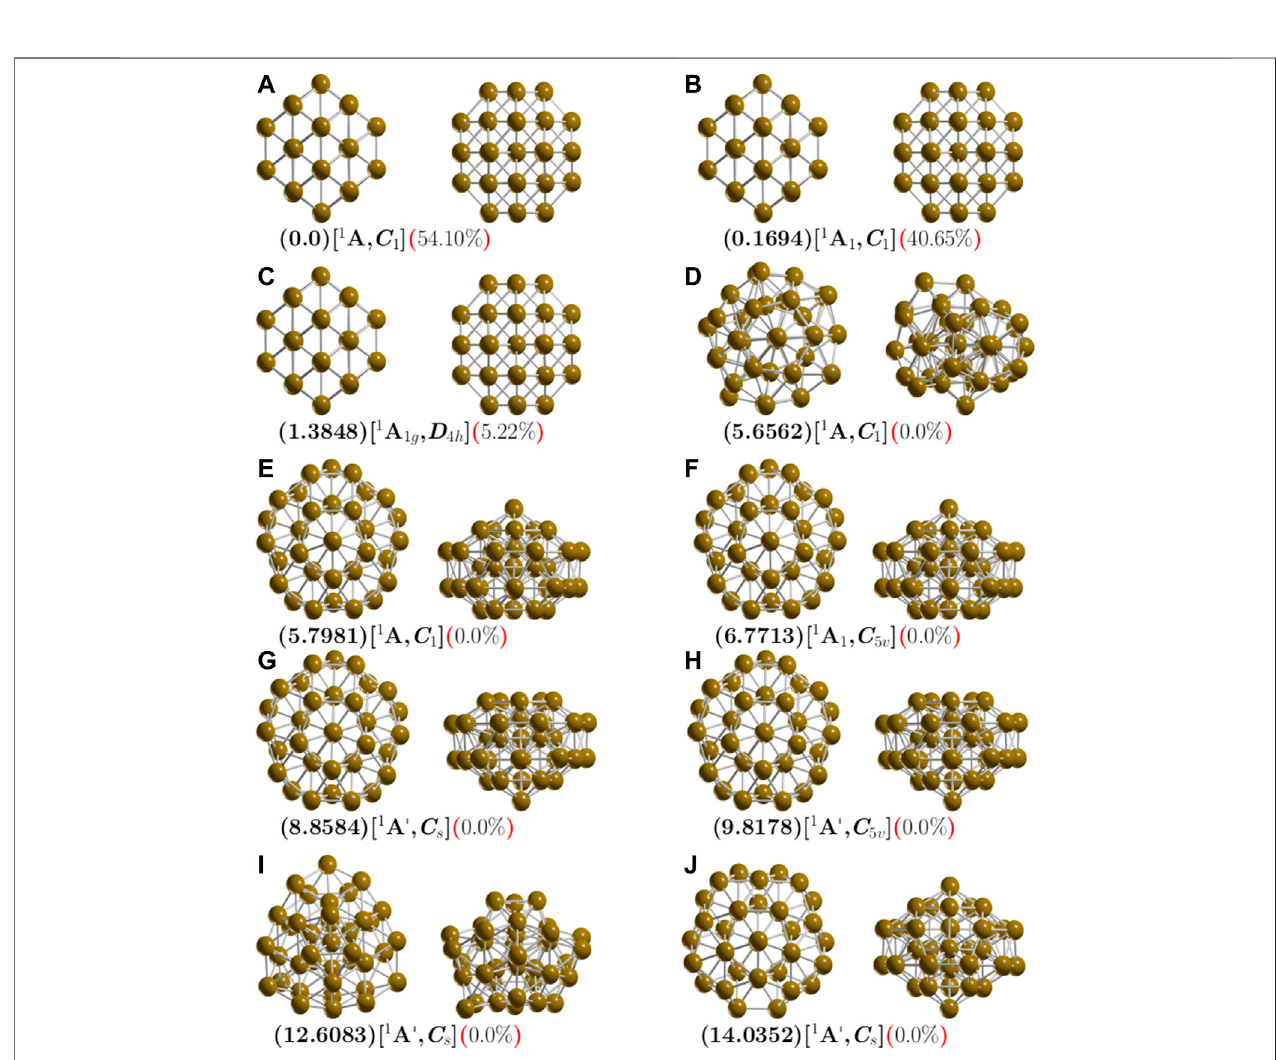
FIGURE 1 | (Color online) Optimized geometries in front and side views of neutral Cu 38 clusters at the PBE-D3/def2-SVP level of theory. The calculations consider the D3 version of Grimme ’ s dispersion corrections and the ZPE correction energy. The fi rst letter is the isomer label, relative Gibbs free energies are in kcal/mol(in round parenthesis)at298.15 K,electronicgroupsandsymmetrypointgroupsare[insquareparenthesis],andtheprobabilityofoccurrenceisshown(inround,redparenthesis) at 298.15 K.